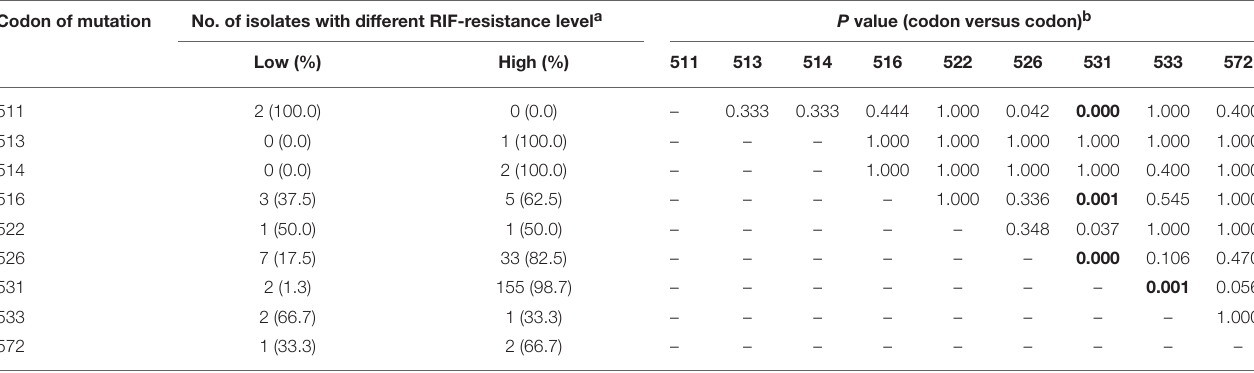
TABLE 3 | Distribution of MTB isolates with different RIF-resistance level. Codon of